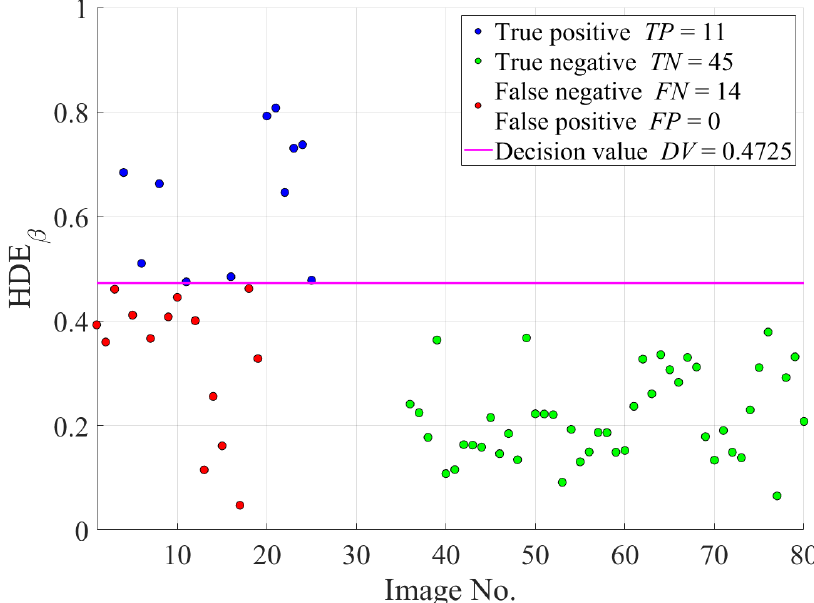
Figure 8. The scatter plot of the HDE β values of images in the IVC and O-HAZE